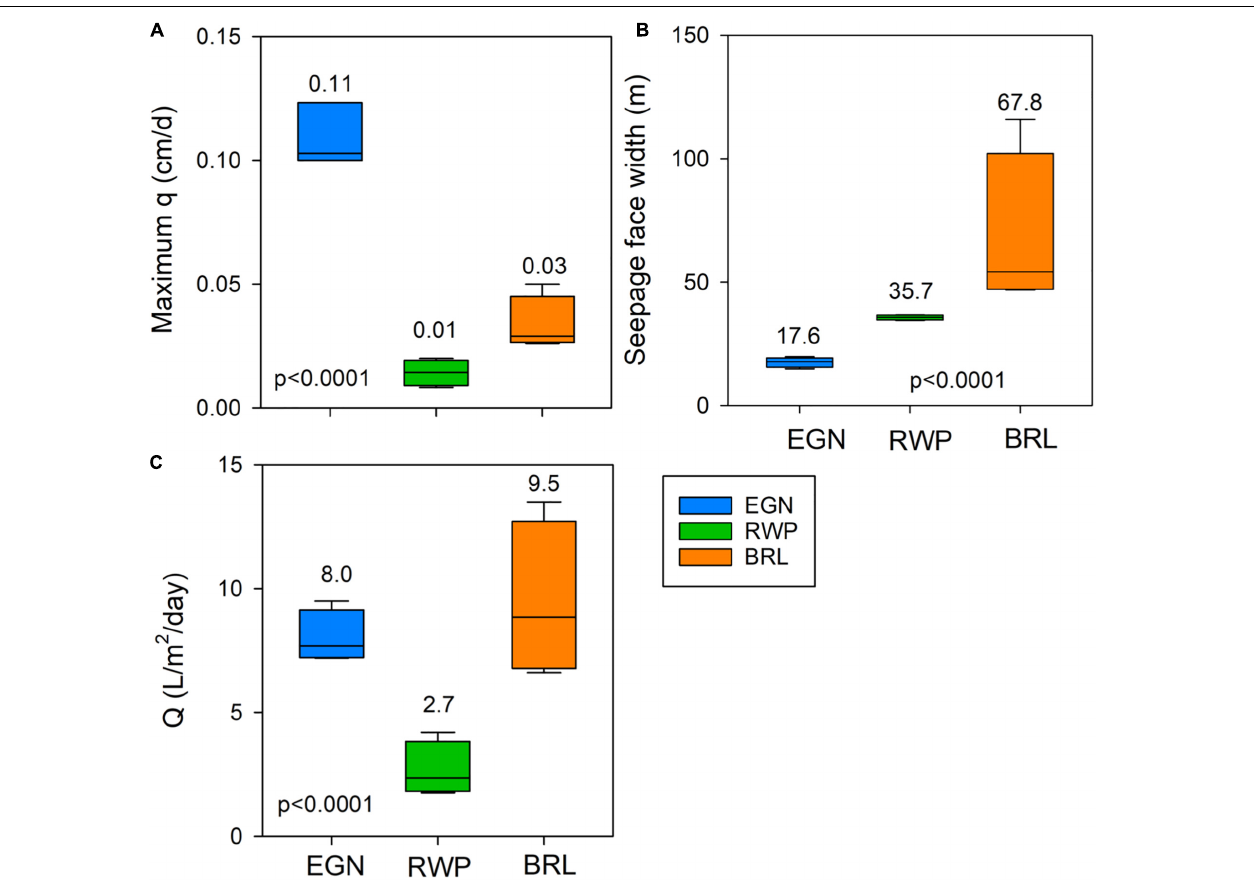
FIGURE 3 | Box plots of the distribution of seepage face hydrologic characteristics over the four sampling campaigns including (A) distribution of maximum groundwater specific discharge (q; cm/day) measured at each sampling time, (B) distribution of seepage face widths measured at each sampling time, and (C) distribution of total seepage face discharge measured at each sampling time. The average value is indicated with a number above each boxplot ( n = 4 in all cases). P -values indicate significant differences among the three sites resulting from one-way ANOVA